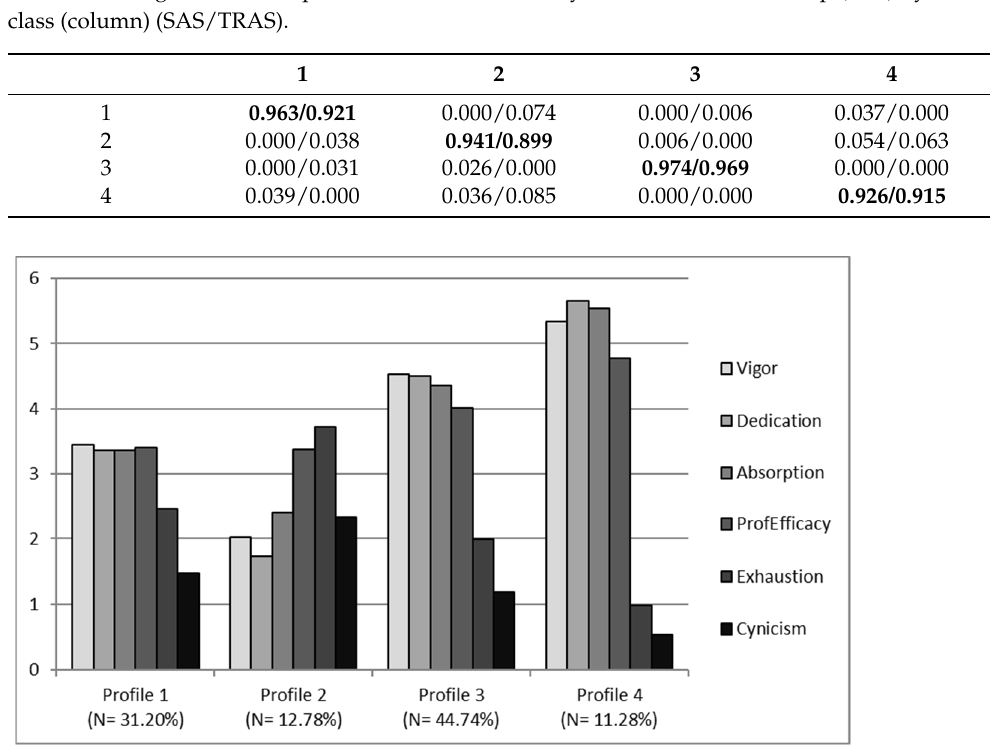
Figure 1. Profile distribution in SAS.